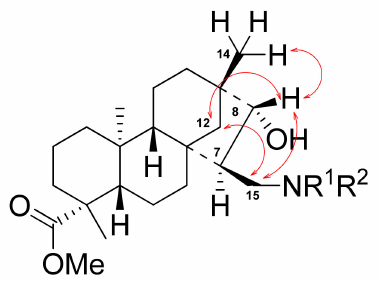
Figure 1. Determination of the structure of 1,3-aminoalcohols by NOESY. Beside the NOESY experiments, the configurations of the newly formed stereocenters of 1,3-aminoalcohols were determined via two alternative synthetic pathways (Scheme 7). Reductive amination of 4 (obtained from 3 with known stereochemistry) with benzylamine with 20b obtained as a major product of the reduction of aminoketone 15 . Alternatively, debenzylation of 20b over 5% Pd/C catalyst in methanol resulted in N -methyl aminoalcohol identical with 7 obtained by reductive amination of 4 with methylamine. Diastereoisomer 24 was also prepared by debenzylation of 20a over 5% Pd/C catalyst (Scheme 7).